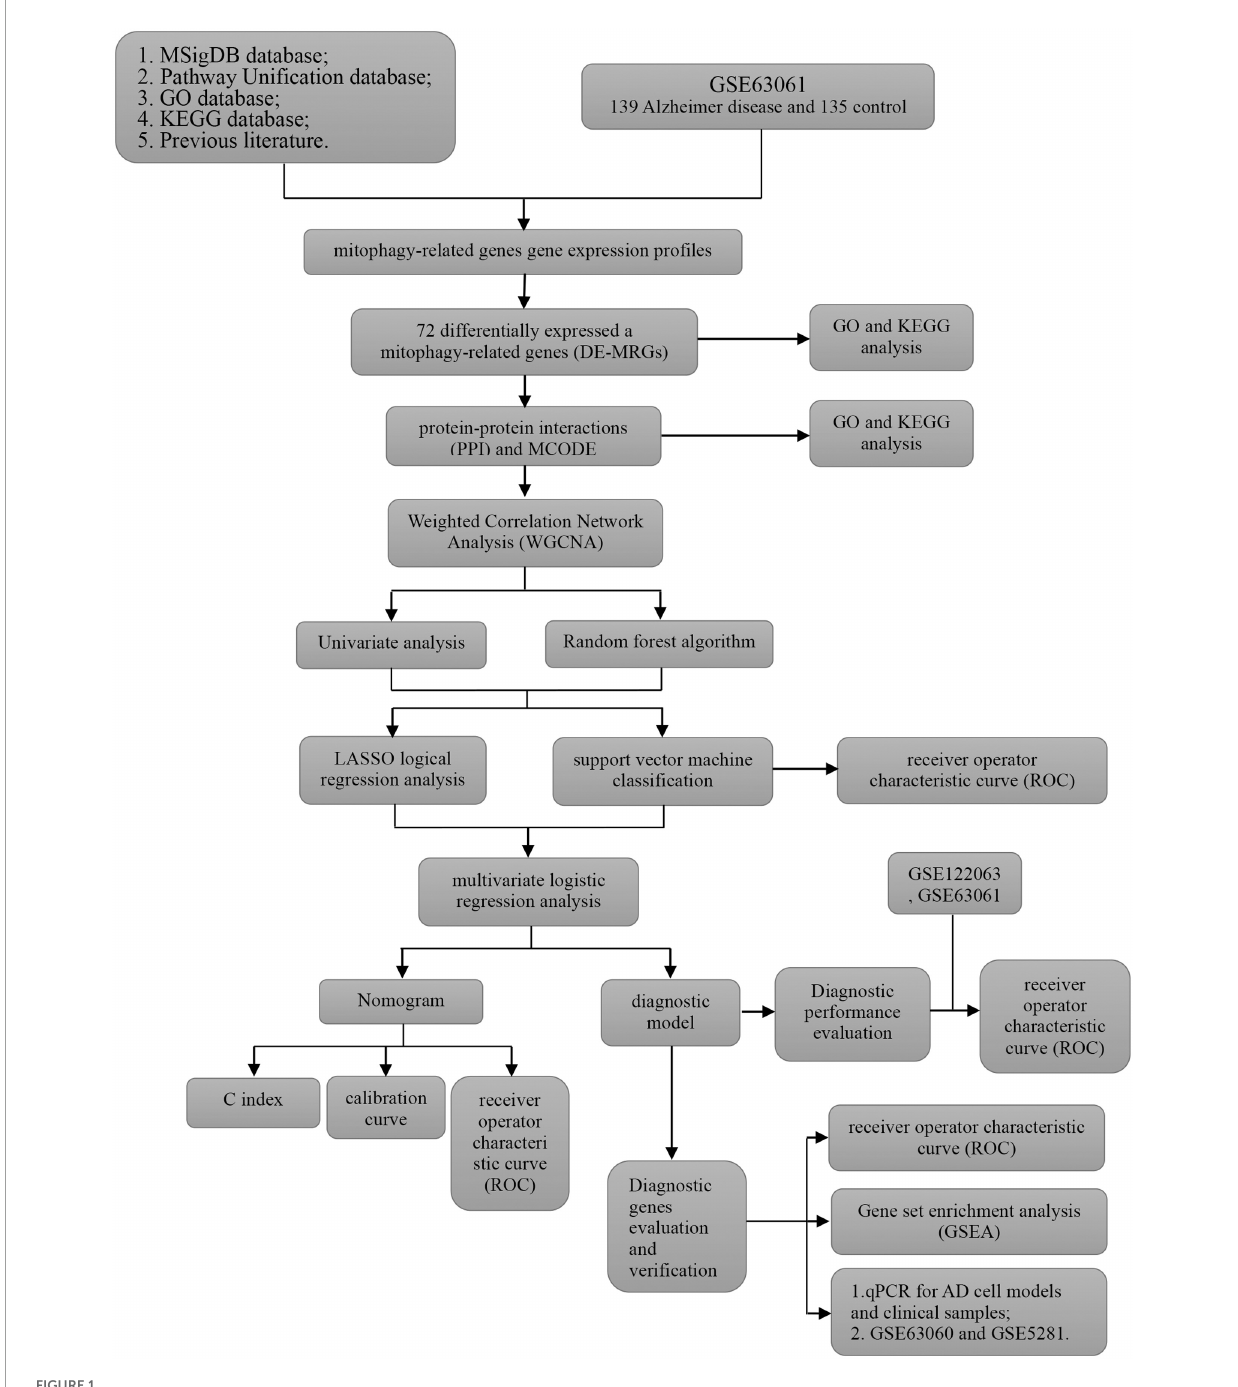
FIGURE1 Overview of the research procedure of this